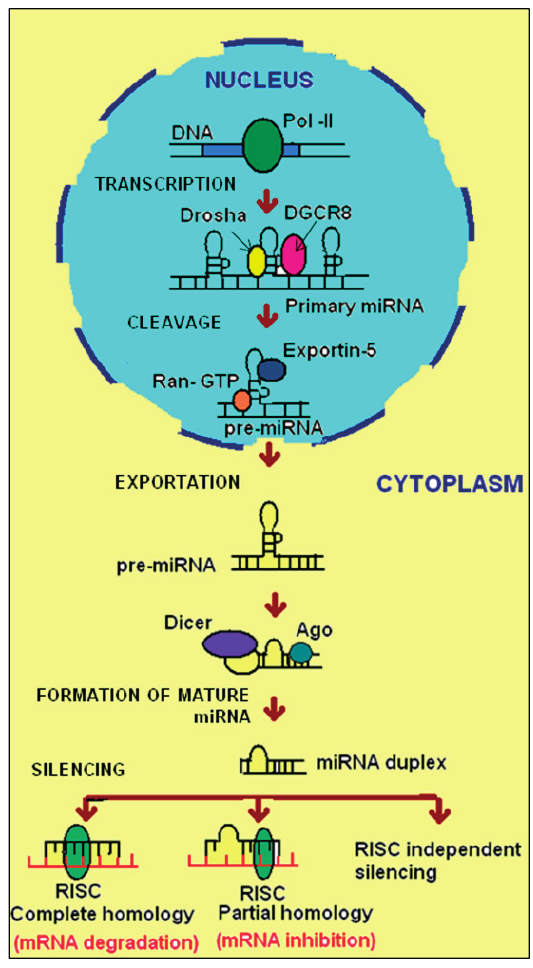
Figure 1. Biogenesis and function of miRNAs. miRNAs are transcribed from specific genes by RNA polymerase II, followed by their cleavage with enzymes Drosha and DGCR8 in the nucleus. The cleaved miRNA is then transported to the cytoplasm by Expotin 5 and Ran GTP where it is further acted upon by the enzyme Dicer to form the mature miRNA duplex. Each strand of the duplex then mediates silencing by either complete base-pairing or incomplete base-pairing with the target mRNA. This reaction is catalyzed by a couple of enzymes which together form the RNA-induced silencing complex